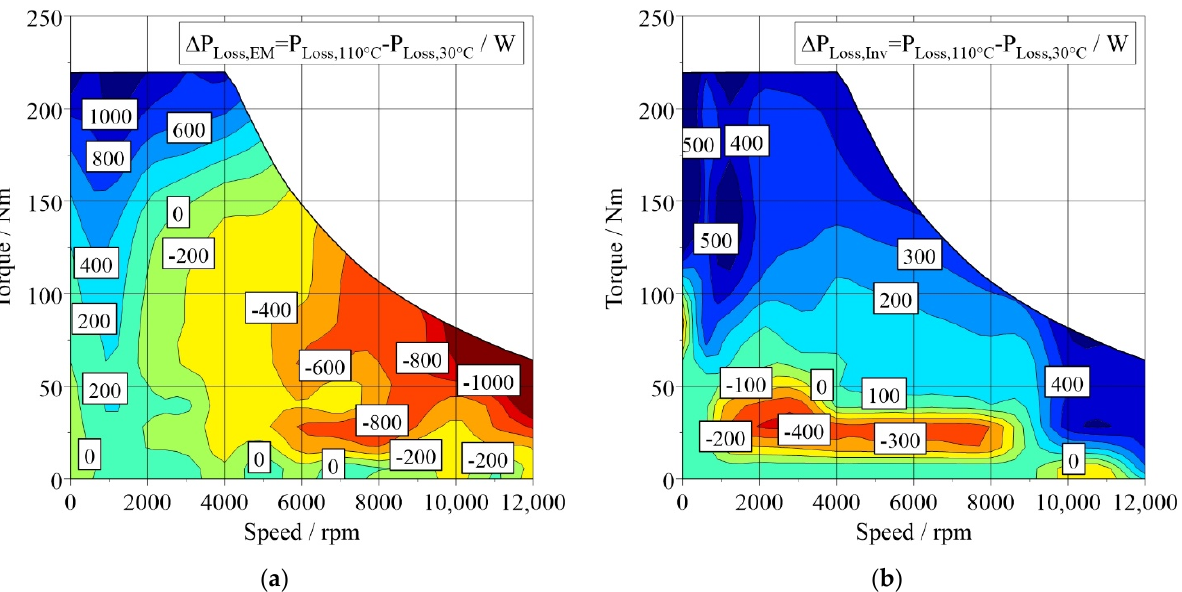
Figure 3. Temperature-dependent losses: ( a ) loss differences for the PMSM when increasing the temperature from 30 °C to 110 °C at 400 V supply voltage; ( b ) loss differences for the inverter when increasing the temperature from 30 °C to 110 °C at 400 V supply voltage.